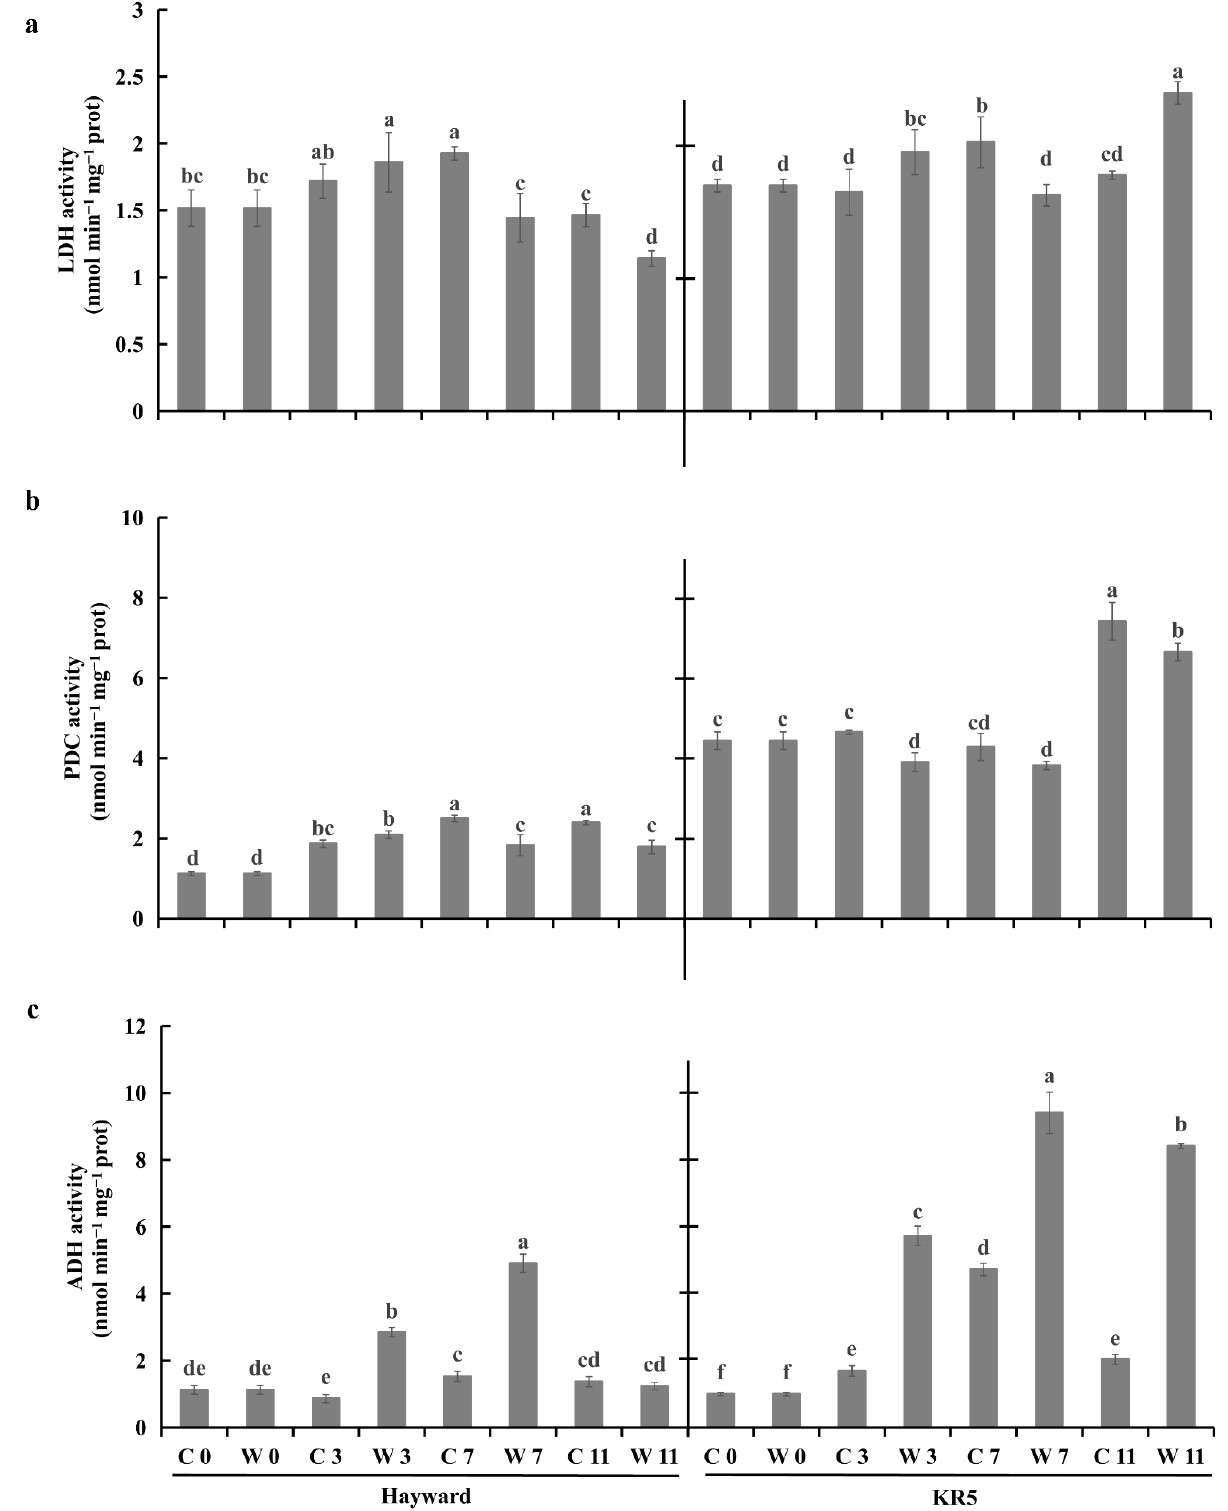
Figure 7. Fermentative enzyme activities in roots of ‘Hayward’ and KR5 under control and waterlogging conditions. ( a ) Lactate dehydrogenase (LDH) activity; ( b ) pyruvate decarboxylase (PDC) activity; and ( c ) alcohol dehydrogenase (ADH) activity. C 0, C 3, C 7, and C 11 indicate 0, 3, 7, and 11-d controls, respectively. W 0, W 3, W 7, and W 11 indicate waterlogging treatments of 0, 3, 7, and 11 d, respectively. Values are the mean ± SD ( n = 3). Significant differences between treatments per genotype at p < 0.05 are indicated by different letters over columns (Duncan’s